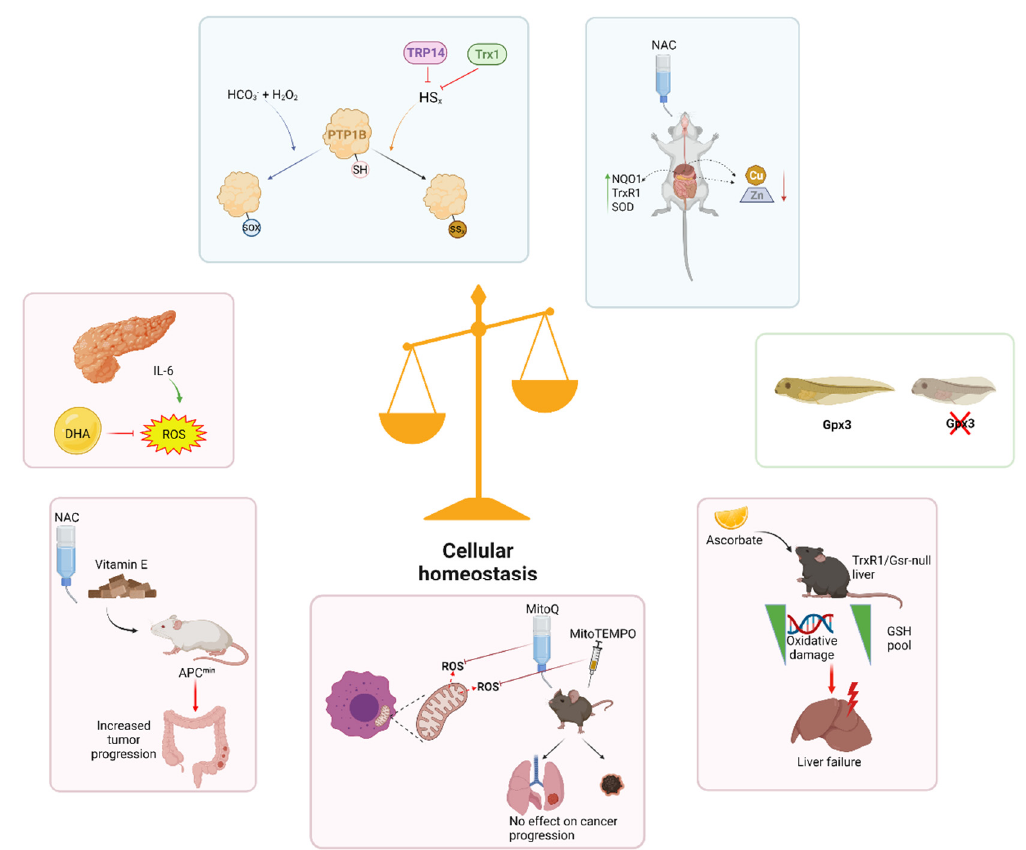
Figure 1. Redox homeostasis plays key roles in the regulation of cell signaling, development, health, and disease. Examples of recent research on cellular redox homeostasis in the areas of cellular signaling, development, and pathology. Created with BioRender.com. TRP14: Trx-like protein of 14 kDa; Trx1: thioredoxin-1; PTP1B: protein tyrosine phosphatase-1B; SH: thiol; SOX: SRG-related high mobility group-box transcription factors; NAC: N- acetyl cysteine; NQO1: NADPH-quinone oxidase; SOD: superoxidase dismutase; IL-6: interleukin-6; ROS: reactive oxygen species; DHA: dehydroascorbate; Gpx3: glutathione peroxidase 3; APC: adenomatous polyposis coli protein; TrxR1: thioredoxin reductase; Gsr: glutathione reductase; GSH: reduced glutathione.